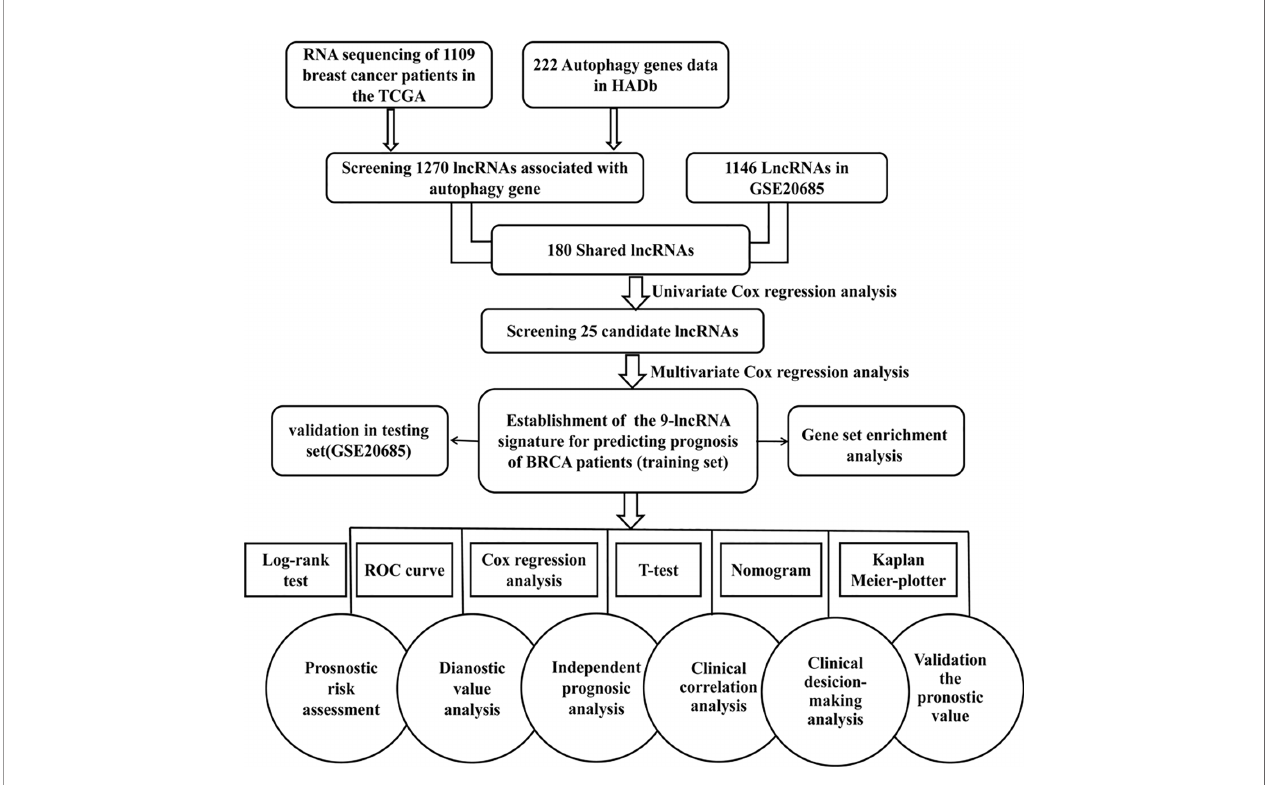
FIGURE 1 | Flowchart for identi fi cation and validation of an autophagy-related lncRNA signature in breast cancer patients. The study was carried out in TCGA and GSE20685 database. The TCGA training set was used to identify prognostic lncRNAs. The multivariate Cox hazard model analysis was performed to construct a prognostic signature based on the prognostic lncRNAs. The prognosis signature was validated in the GSE20685 testing